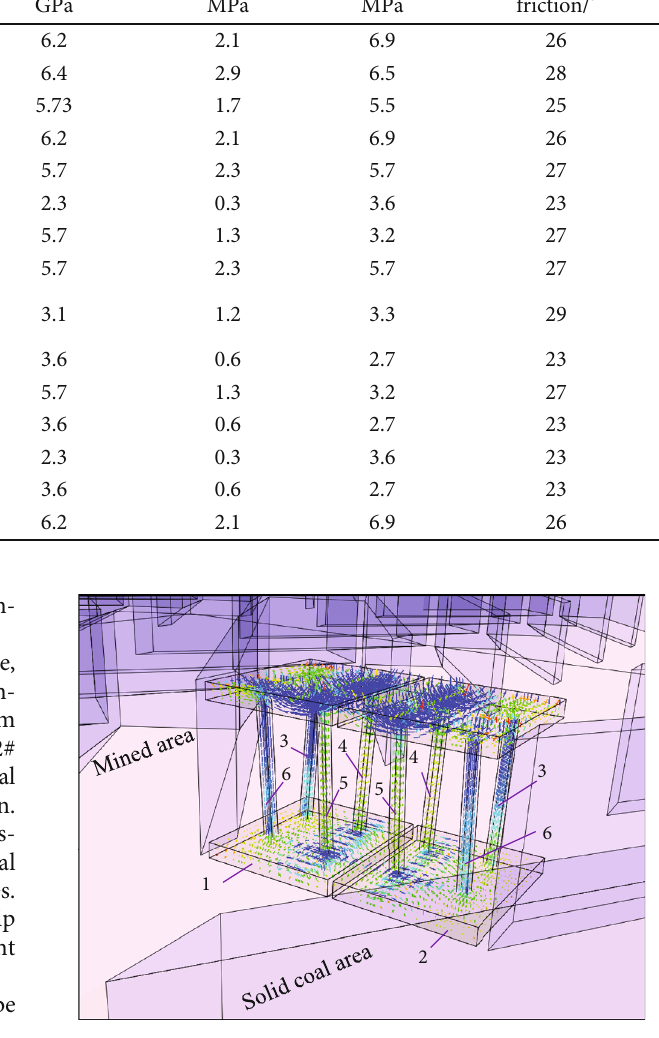
Figure 4: Modeling diagram of the short-wall working face with two PP supports (1-1# PP support; 2-2# PP support; 3-side and rear pillars; 4-middle and rear pillars; 5-middle front pillars; 6- side front